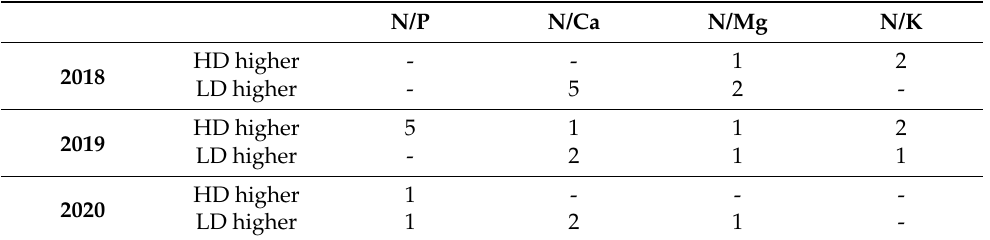
Table 4. Number of plots with significantly higher foliar ratios in each defoliation category within sampling years determined by the independent samples t -test (total number of plots: